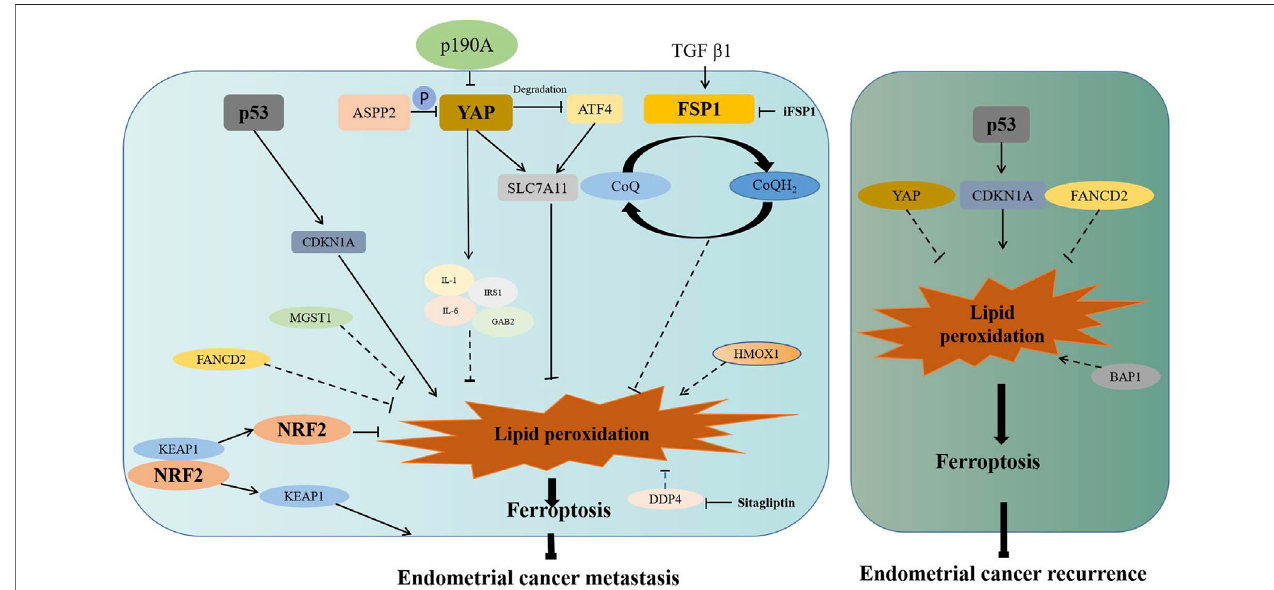
FIGURE 2 | Association of ferroptosis-associated genes with metastasis or recurrence of endometrial cancer. ASSP2 and p190A inhibit migration of endometrial cancer via inactivatingtheHippo – YAPsignalingpathway.YAPpromotestheexpressionofSLC7A11directlyorthroughinhibitingATF4degradation.YAPalsopromotes the increase of IL-6, IL-1, IRS1, and GAB2, which may inhibit lipid peroxidation to promote invasion or migration. TGF β 1promotes the expression of FSP1, which inhibit lipid peroxidation to promote invasion or migration. After Nrf2 dissociated from KEAP1, activated Nrf2 inhibits lipid peroxidation to promote invasion or migration. p53 enhances the expression of CDKN1A to promote lipid peroxidation. MGST1, FANCD2, and DDP4 may promote invasion or migration through inhibiting lipid peroxidation and ferroptosis. HOMX1 may restrain invasion or migration through promoting lipid peroxidation and ferroptosis. Moreover, increased ubiquitinated degradation of p53 results in the decreased expression of CDKN1A, which results in reduced ferroptosis and enhanced recurrence. FANCD2 and YAP may promote recurrence through inhibiting lipid peroxidation and ferroptosis. BAP1 may prevent recurrence through promoting lipid peroxidation and ferroptosis. P in the graph represents